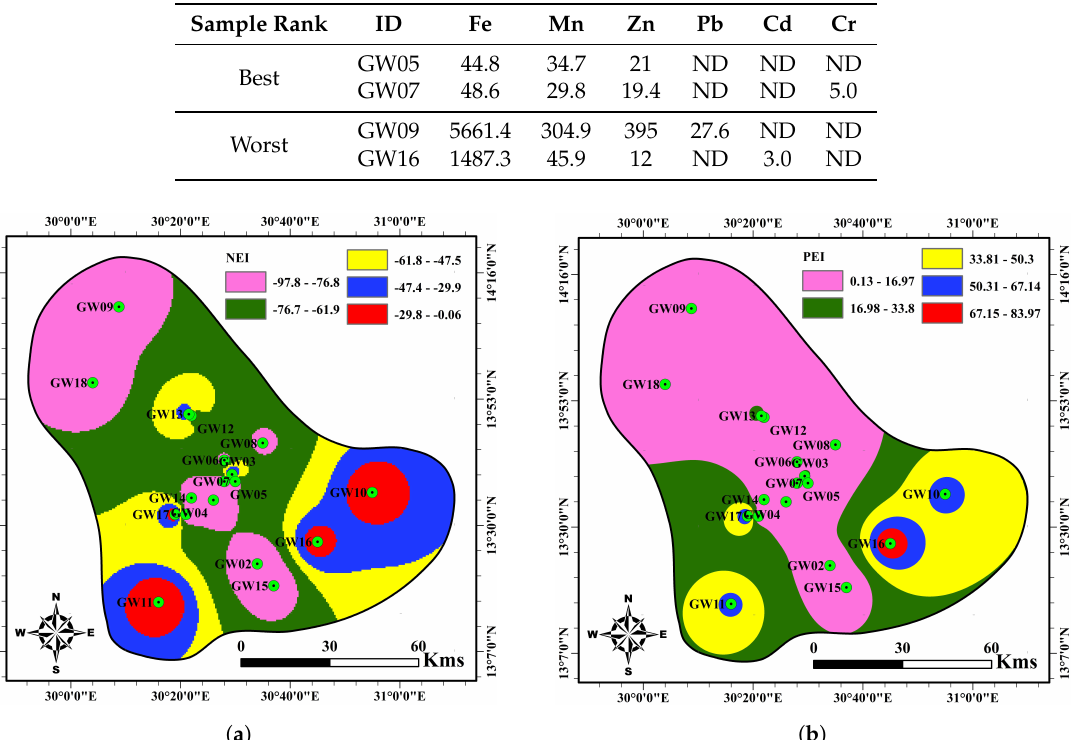
Table 10. Concentrations of heavy metal ions ( µ g/L) in the best and worst groundwater samples in the study area.